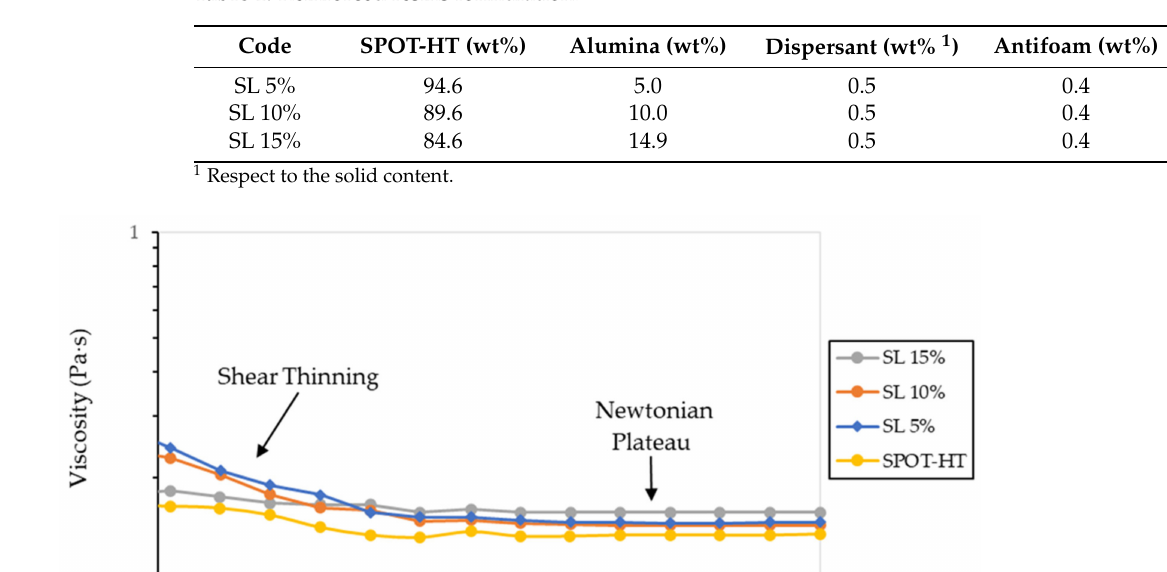
Table 1. Reinforced resins formulation.